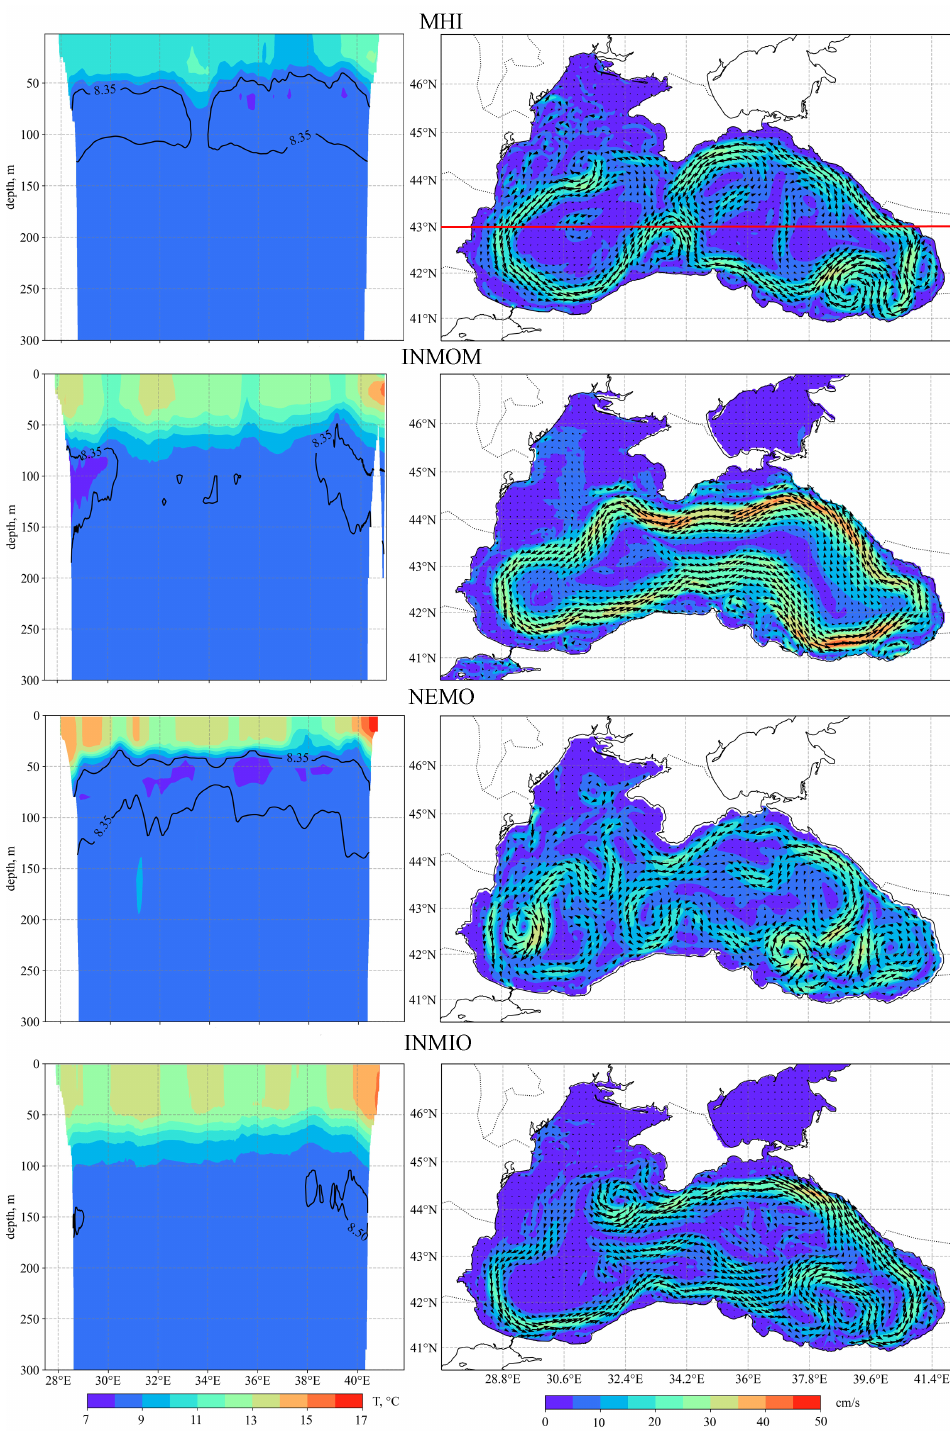
Figure 3. The same as Figure 2, but for December